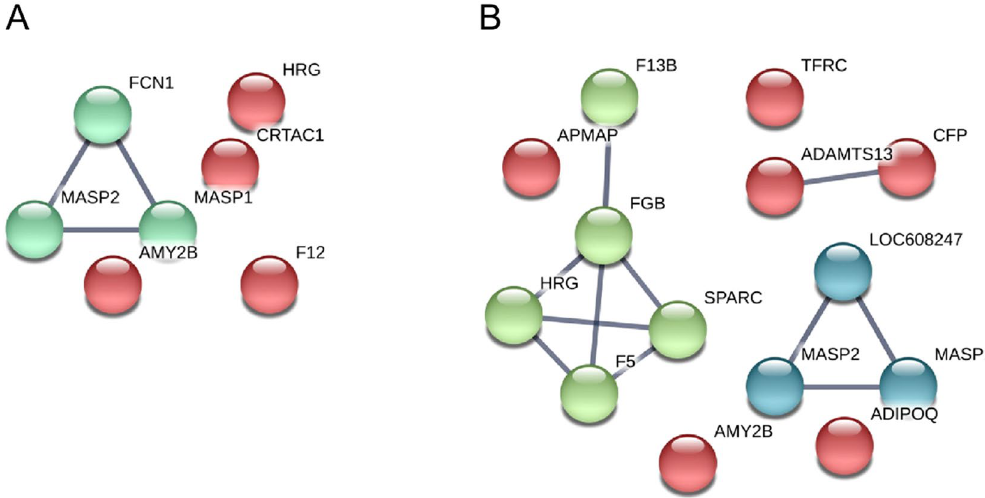
Figure 2. Functional protein–protein interactions among downregulated proteins. ( A ) downregulated proteins at day 34 compared to day-7, ( B ) downregulated proteins at day 75 compared to day-7. ADAMTS13 ADAM metallopeptidase with thrombospondin type 1 motif 13, ADIPOQ adiponectin precursor, AMY2B amylase α2B, APMAP adipocyte plasma membrane associated protein, CFP complement factor properdin, CRTAC1 cartilage acidic protein 1, F12 coagulation factor XII, F13B coagulation factor XIII, polypeptide B, F5 coagulation factor V, FCN1/LOC608247 ficolin (collagen/fibrinogen containing lectin) 1, FGB fibrinogen β chain, HRG histidine- rich glycoprotein, MASP1 mannan-binding lectin serine peptidase 1, MASP2 mannan-binding lectin serine peptidase 2, SPARC secreted protein acidic, cysteine-rich, TRFC transferrin receptor protein